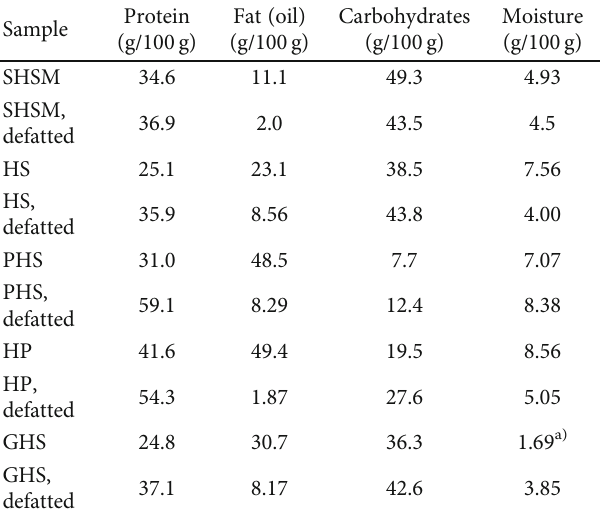
Table 1: Basic composition of raw materials and defatted samples.